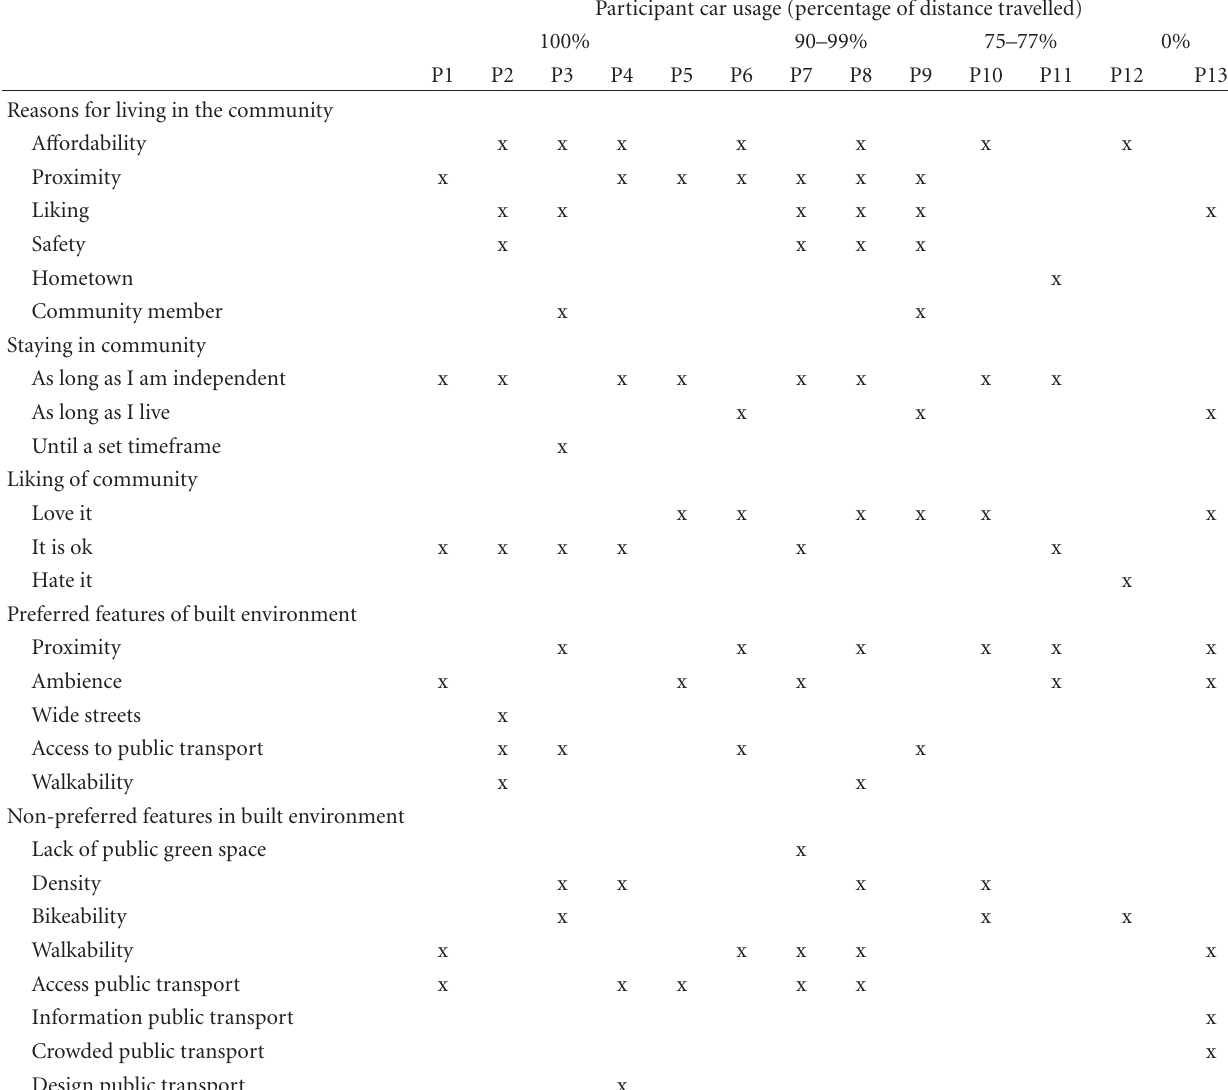
Table 2: Preferred and Non-preferred features of built